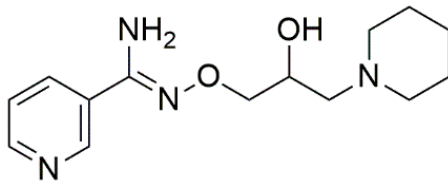
Figure 6. Chemical structure of O -(3-piperidino-2-hydroxy-1-propyl)-nicotinic amidoxime, known